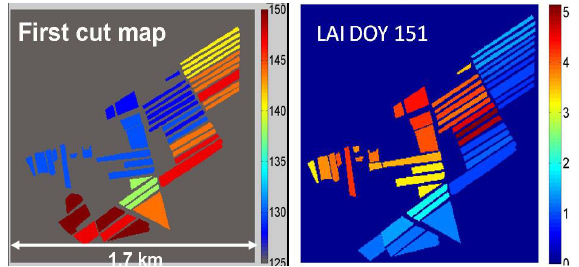
Figure 4. The first mowing date (in DOY) mapped from the simplified algorithm described in Sect. 3.2, LAI (m²/m²) map obtained from the eq 2, on DOY 151 (31 May 2006).